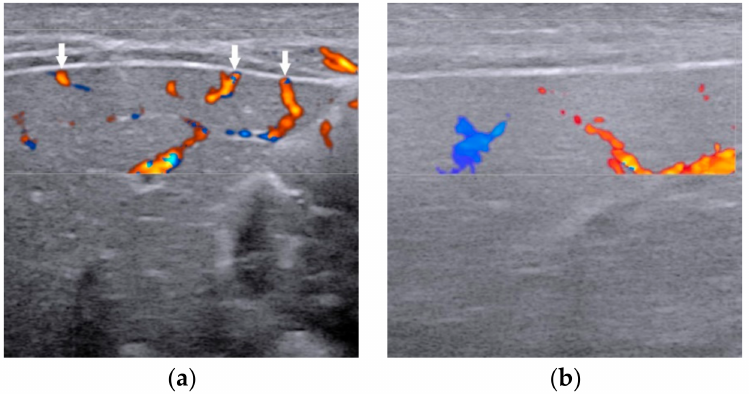
Figure 6. The presence of hepatic subcapsular flow (arrows) in biliary atresia ( a ) and the absence of hepatic subcapsular flow in non-biliary atresia ( b